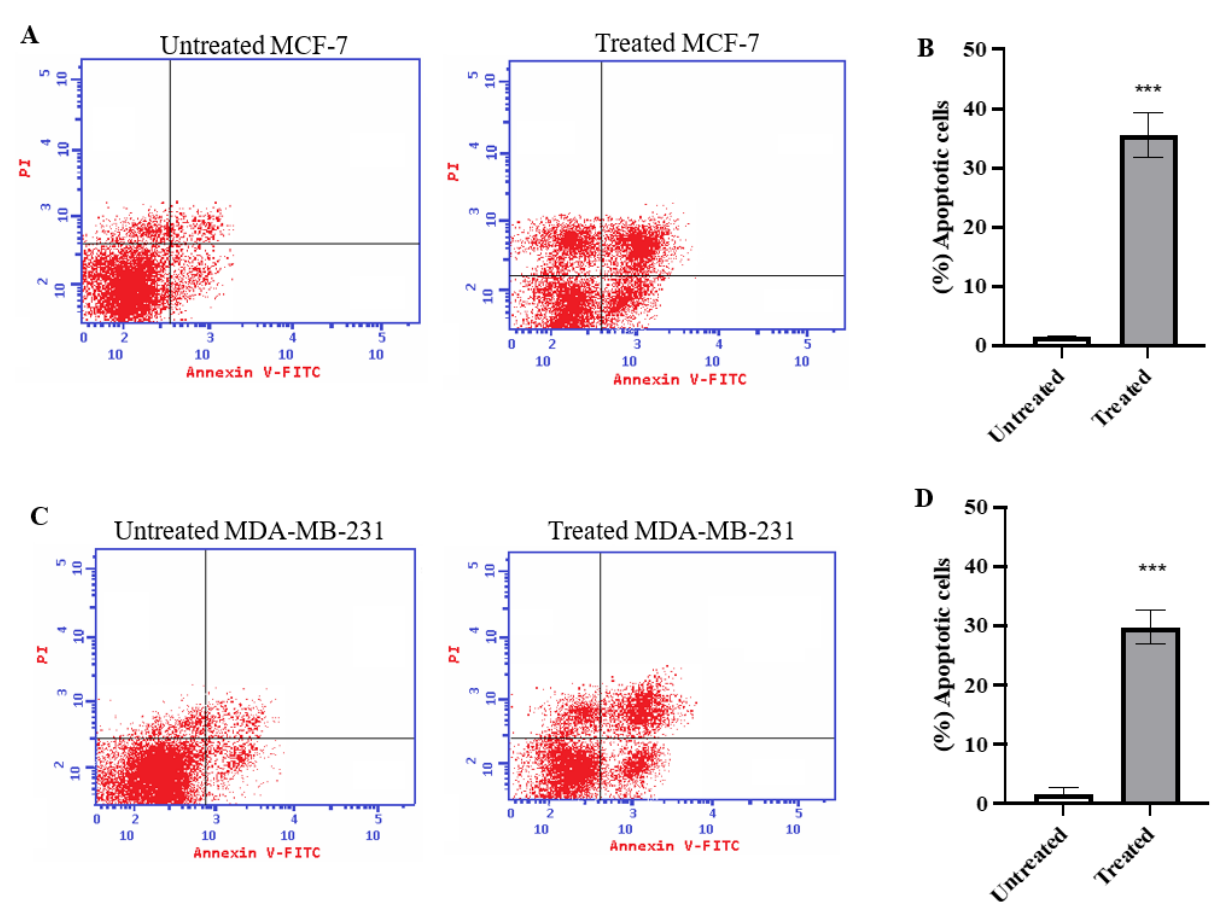
Figure 2. Effect of azilsartan on apoptosis of MCF-7 and MDA-MB-231 breast cancer cell lines estimated with Annexin V staining. ( A , C ) Representative dot plots for MCF-7 and MDA-MB-231 breast cancer cell lines, respectively. ( B , D ) The percentage of total apoptotic cells in MCF-7 and MDA-MB-231 breast cancer cell lines, respectively, after treatment with the IC 50 of azilsartan for 48 h. Data represent mean ± SD, n =3. Significant difference was analyzed by one-way ANOVA test, where *** p < 0.001, compared to untreated cells.